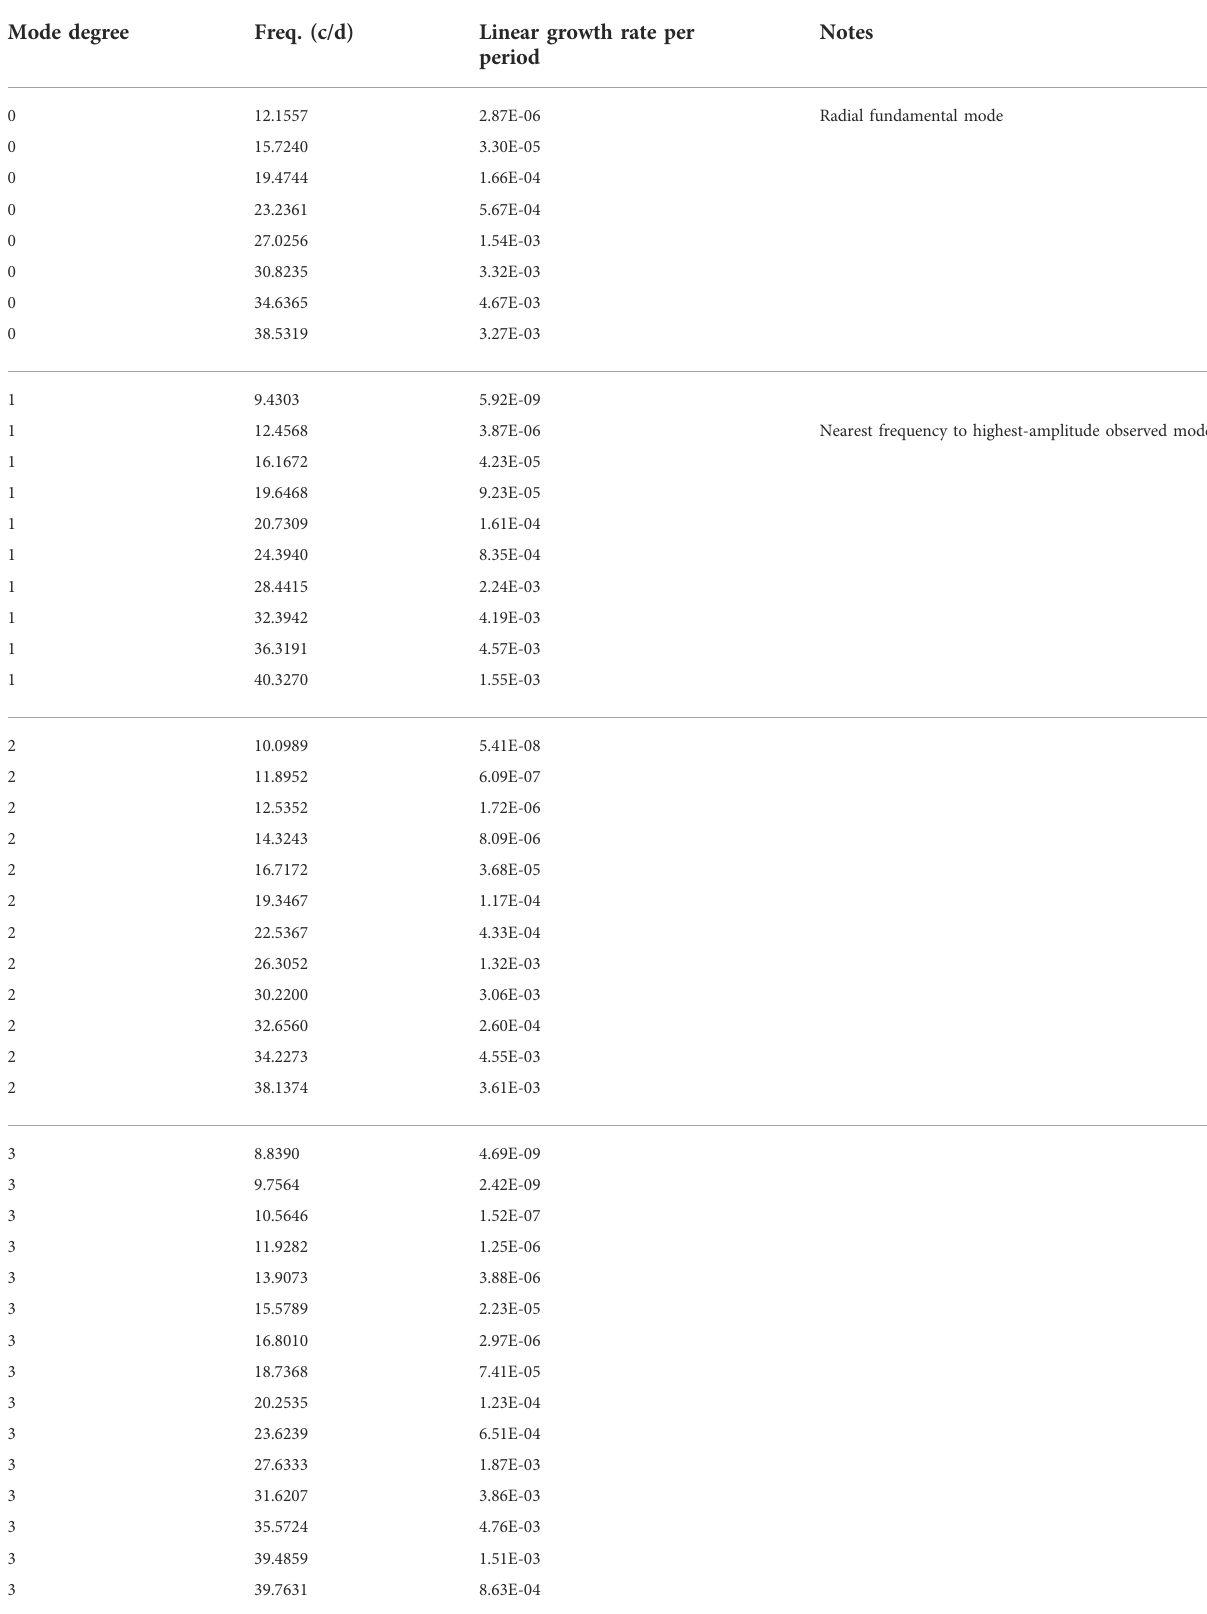
TABLE 3 Unstable low-degree frequencies of 1.82 M ⊙ FG Vir